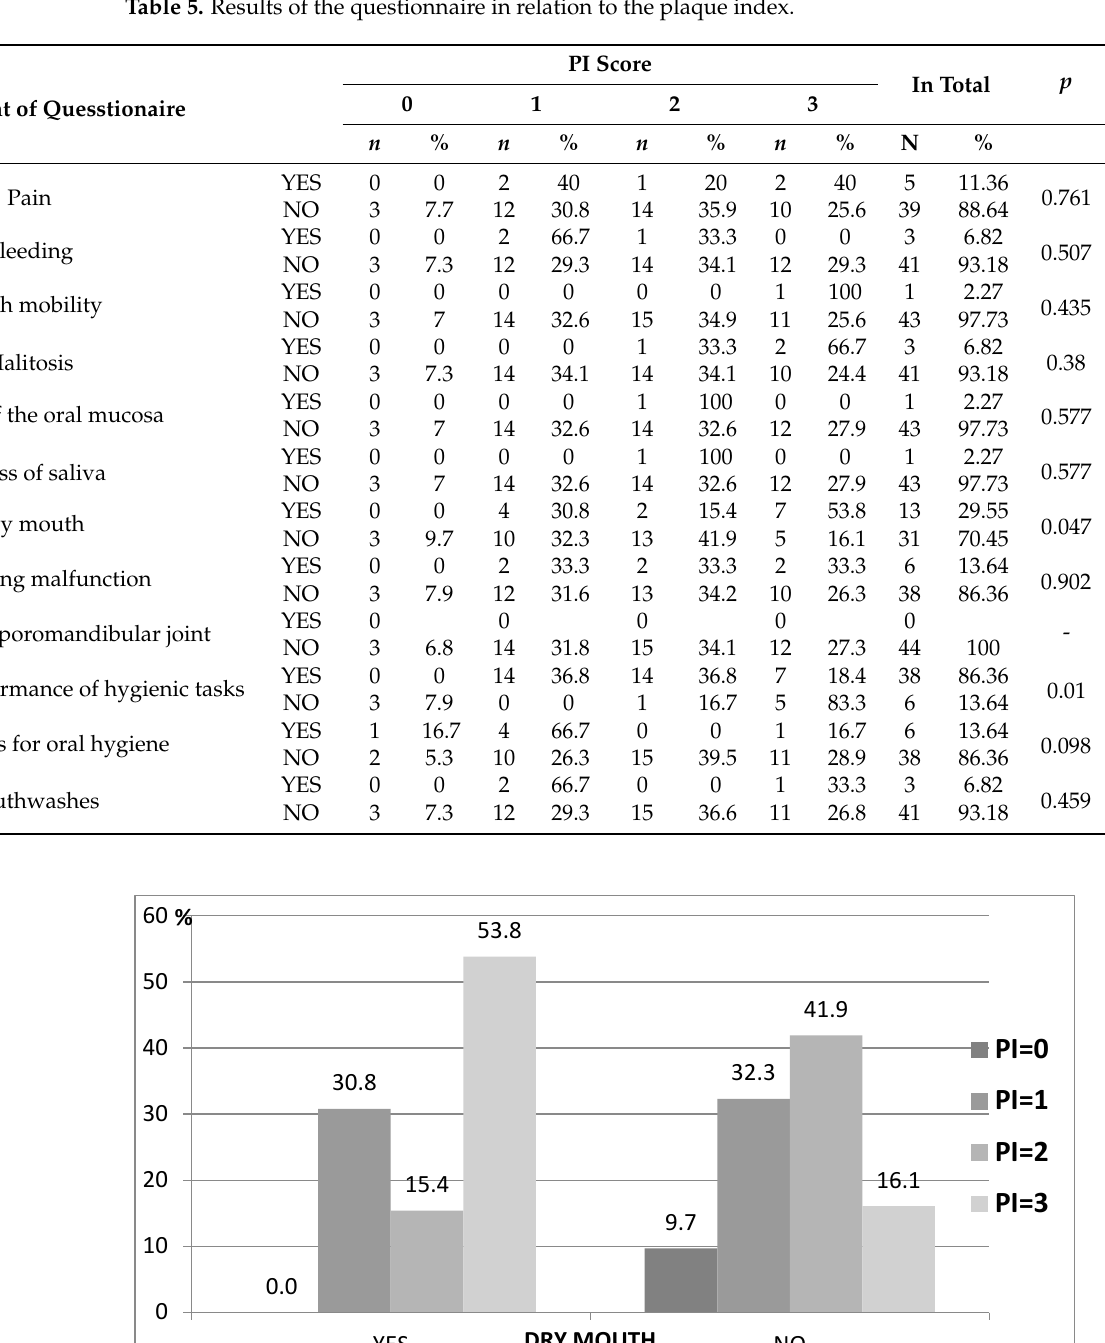
Table 5. Results of the questionnaire in relation to the plaque index.